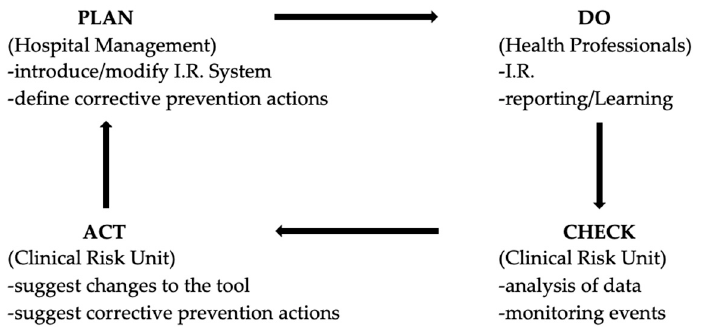
Figure 1. Clinical Risk Management Cycle.